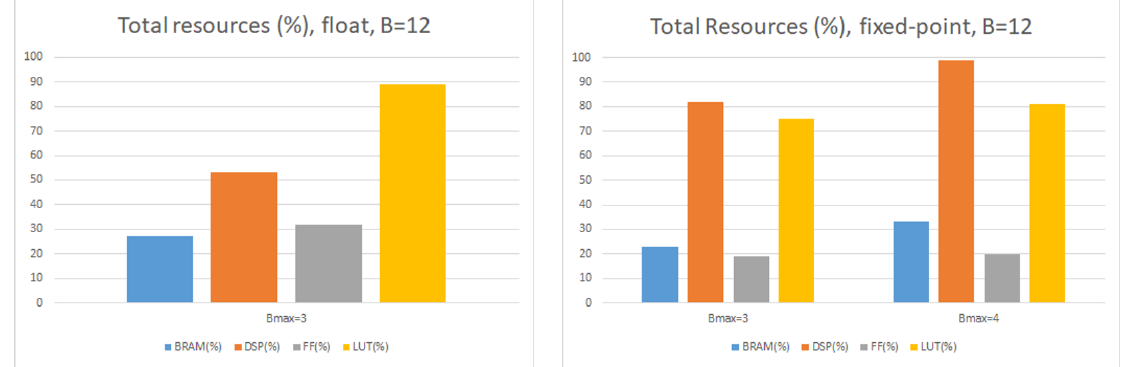
Figure 12. Resource usage for Zedboard for fixed- and floating-point design, B = 12, pixels = 300 × 300.